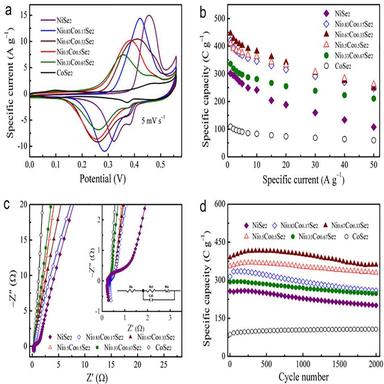
(a) CV curves at 5 mV s1 , (b) Specific capacity at different specific currents, (c) Nyquist plots and (d) cycling performances of the Ni–Co selenides.